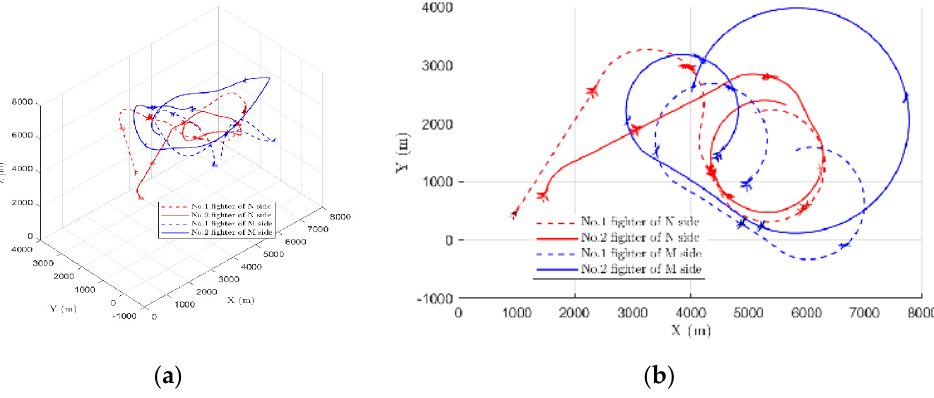
Figure 4. The air combat flight trajectories of four fighters. ( a ) The three-dimensional flight trajectory diagram; ( b ) The two-dimensional flight trajectory diagram.